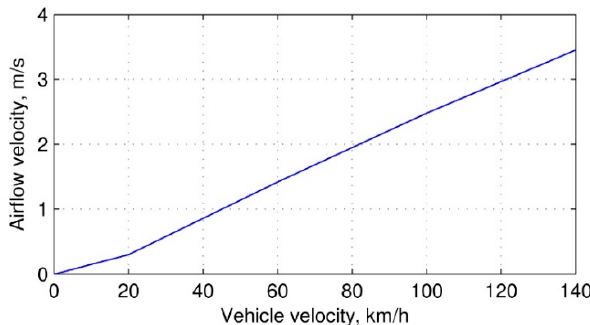
Figure 6. Velocity of the airflow passing through the radiator as a function of the vehicle velocity.